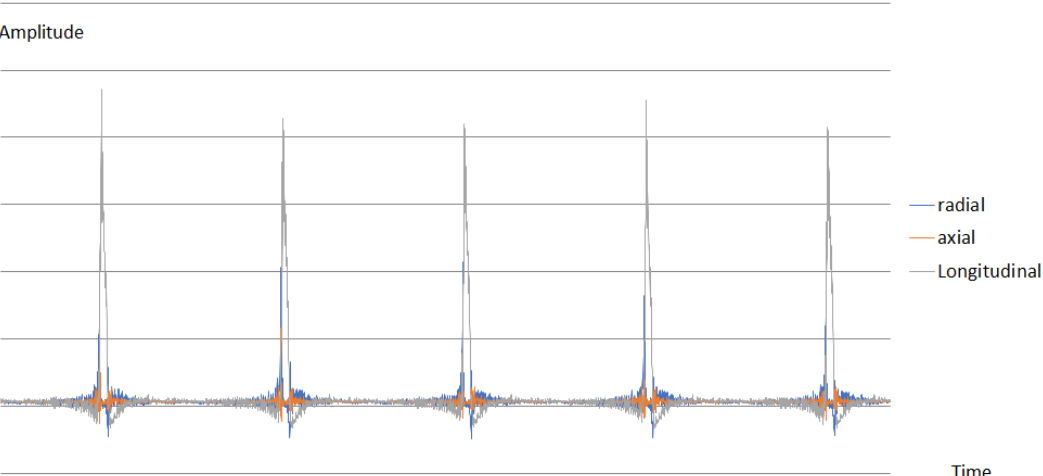
Figure 10. Longitudinal, radial, and axial data.